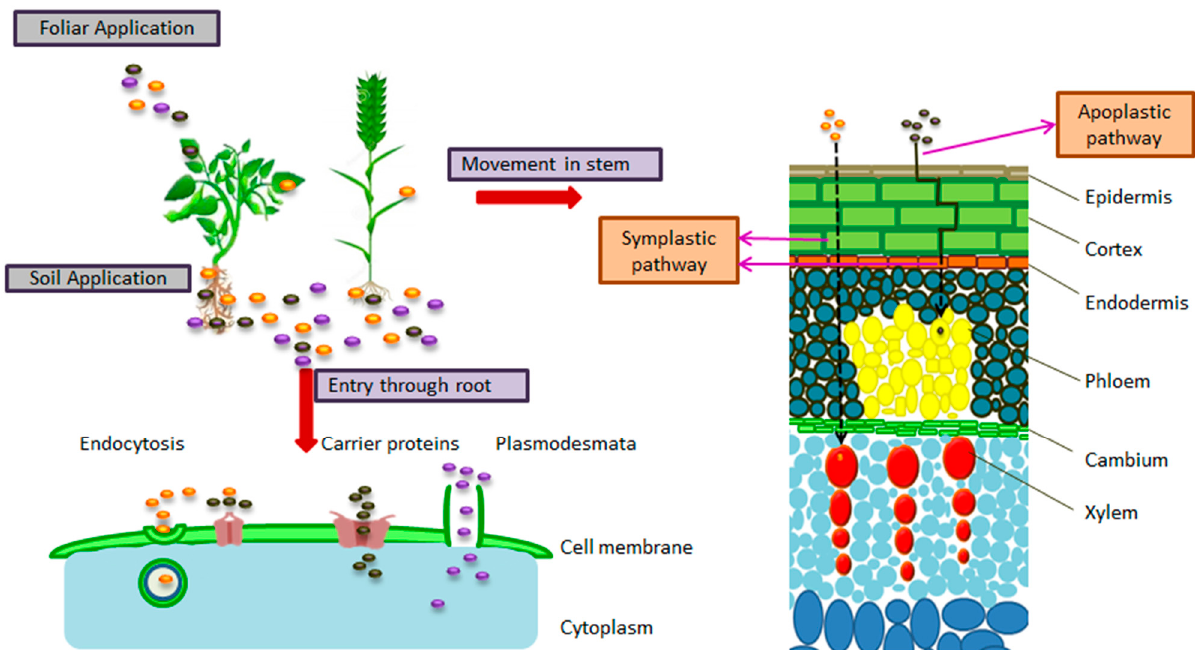
Figure 2. Uptake and movement of nanoparticles in plants.